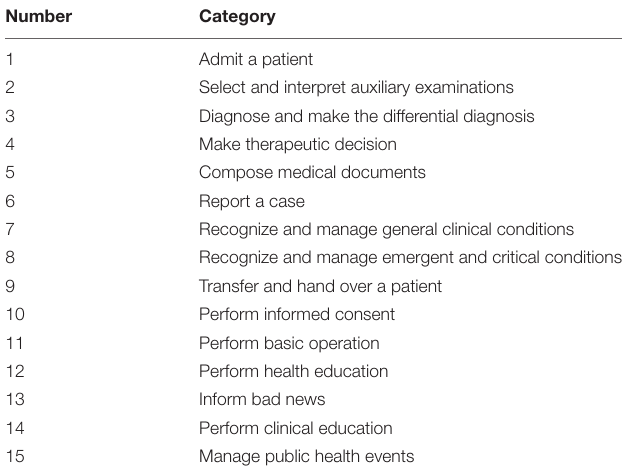
TABLE 1 | Entrustable professional activities (EPAs)